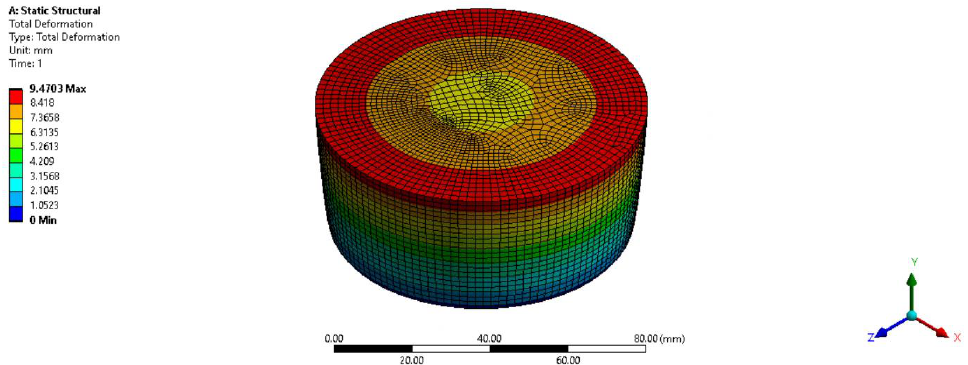
Figure 13. Reduced stresses of the tested specimen (deformed state).